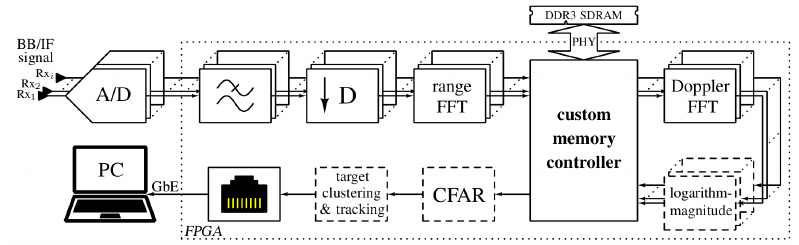
Figure 4. A block diagram of a typical range-Doppler processing back-end. Optional blocks such as logarithm–magnitude, CFAR, and target clustering and tracking are drawn with dashed